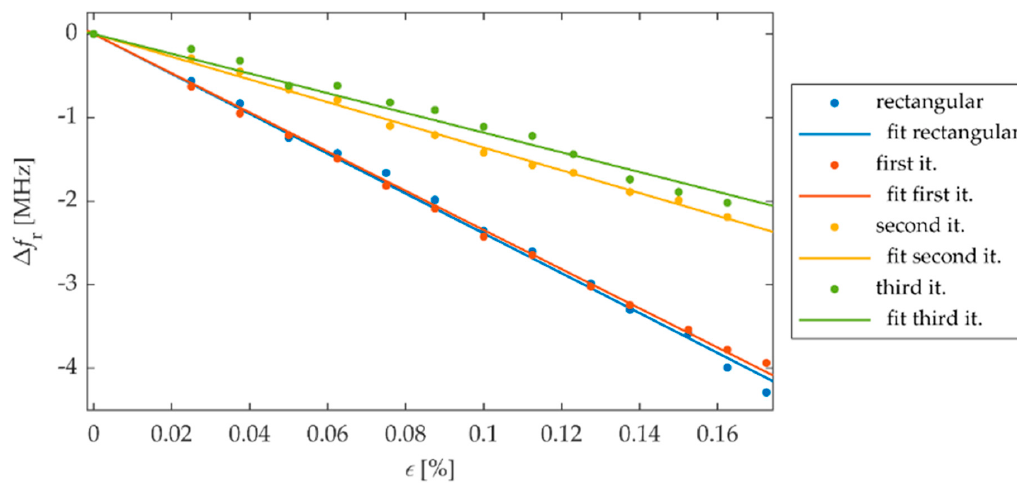
Figure 11. Dependencies between strain ε and shifts of resonant frequency Δ f r for proposed sensors received in measurement.